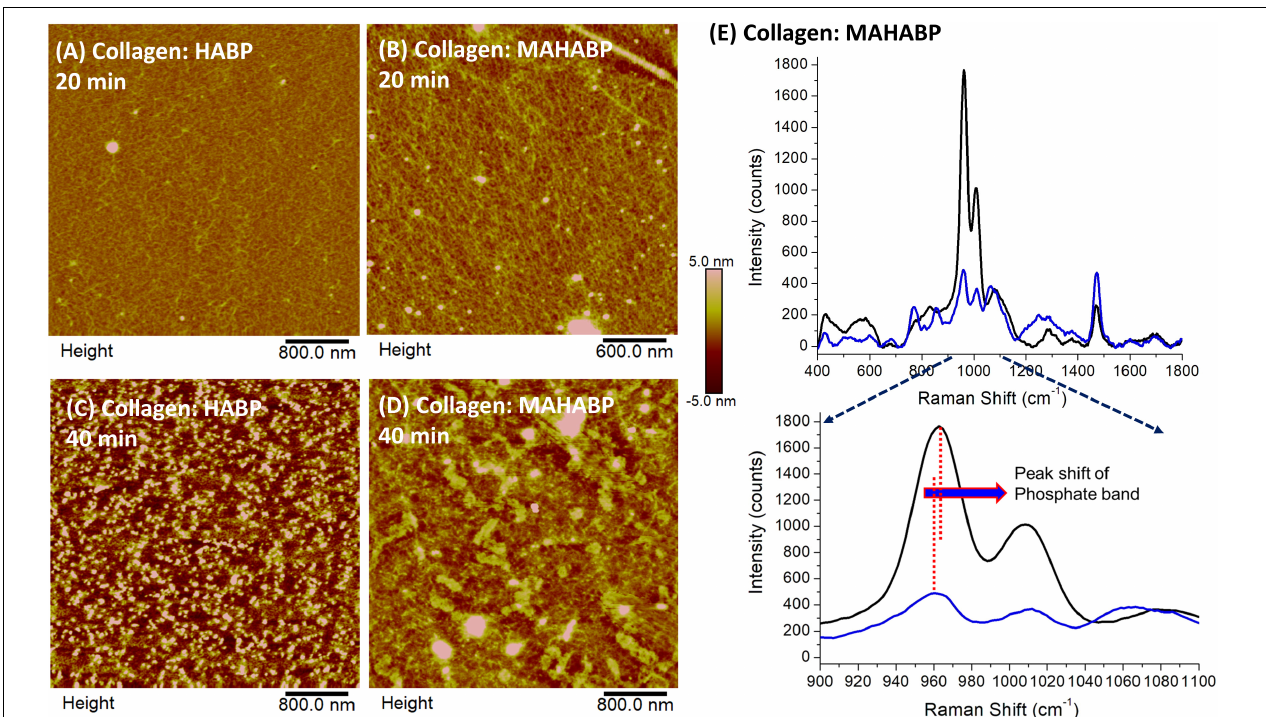
FIGURE 6 | AFM images of peptide-functionalized collagen model surfaces after alkaline phosphatase mediated mineralization and their Raman spectra. (A) Collagen: HABP after 20 min; (B) collagen: MAHABP after 20 min (C) collagen: HABP after 40 min; (D) collagen:MAHABP after 40 min (E) Raman spectra of the minerals grown on the MAHABP-functionalized collagen model surfaces at 20 min and longer